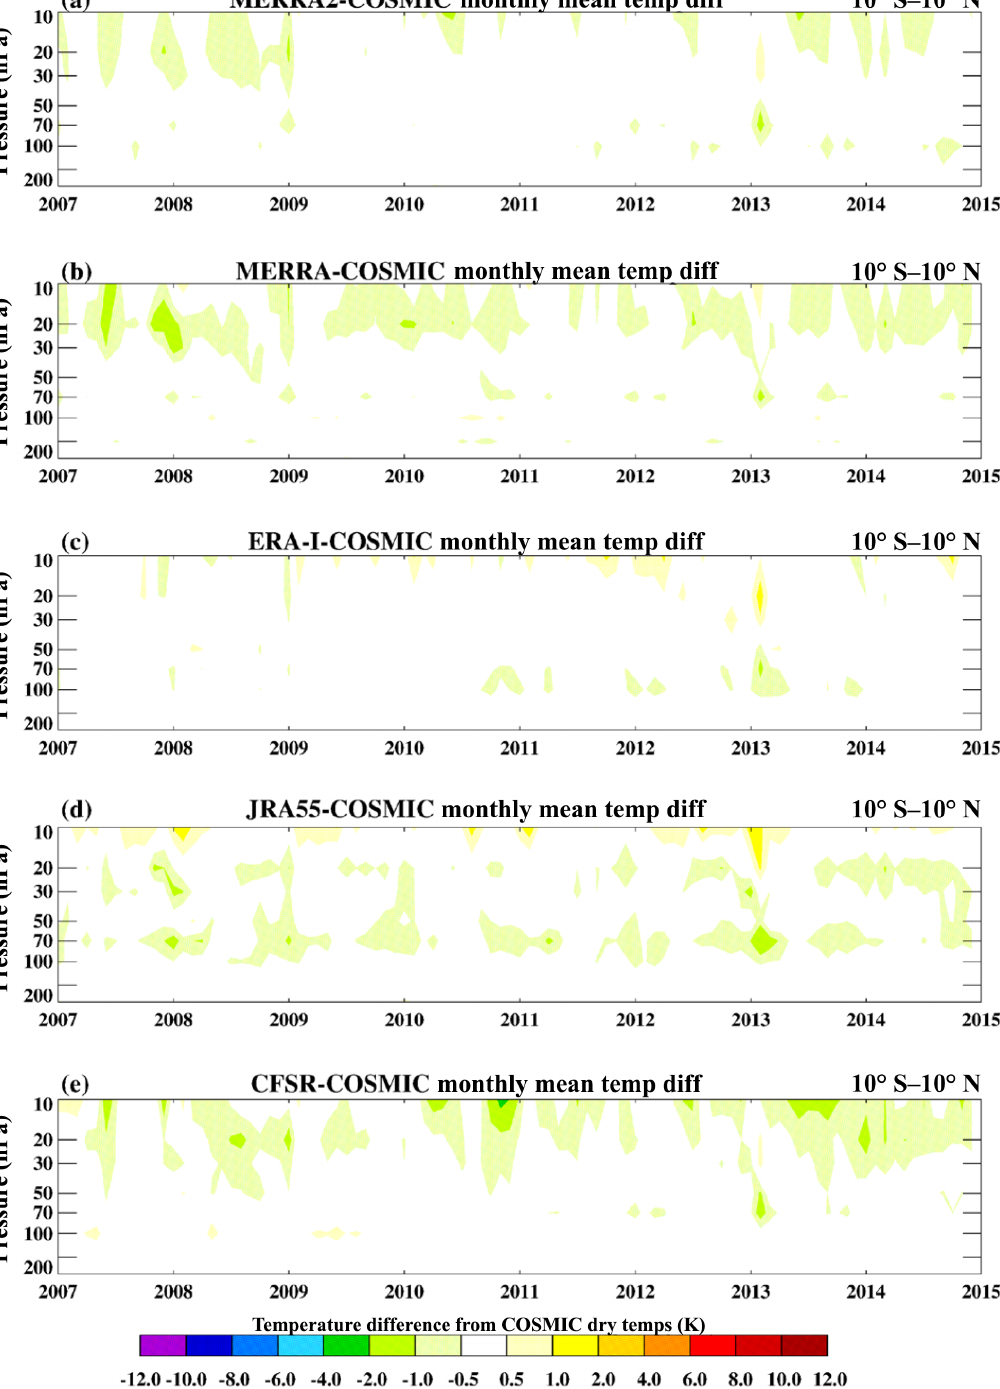
(TLS) are available from the MSU-4 and AMSU-A9 mi- crowave channels, while the Stratospheric Sounding Unit channel 1 (SSU1) and channel 2 (SSU2) provide temper-